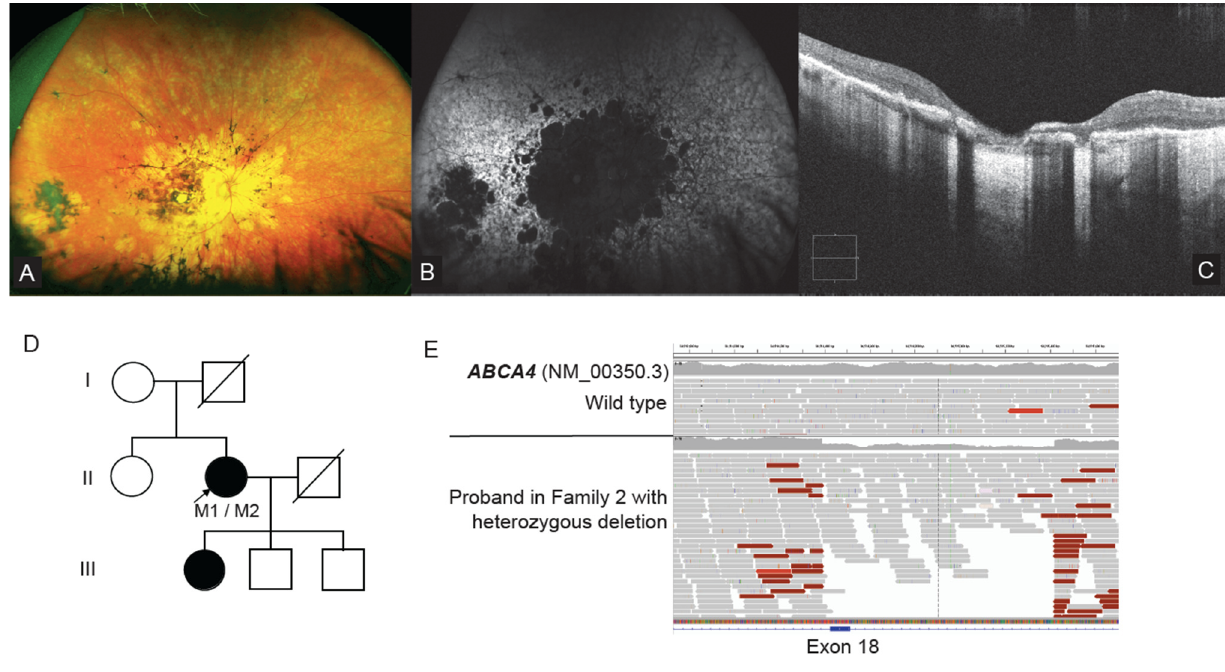
Figure 5. WGS resolves single exon CNV in ABCA4 . ( A ) Ultra-Wide field pseudo colour fundus images show significant atrophy involving the posterior pole in each eye. There was blotchy retinal atrophy extending to the equator in each eye; ( B ) UWF-FAF shows dense loss of autofluorescence in the posterior pole of both eyes extending beyond the vascular arcades with coalescing paving stone like areas of dense hypo autofluorescence. In the periphery there is patchy areas of hyper and hypo autofluorescence; ( C ) OCT showed almost complete loss of the outer retinal layers at the macular with significant disruption and loss of the EZ in the para macular region; ( D ) Pedigree of Family 6. M1 = ABCA4 :c.5461-10T>C, M2 = ABCA4 exon 18 deletion; ( E ) IGV screenshot of the 1029bp deletion involving ABCA4 exon 18, plus flanking intronic segments. Genomic deletion is describable as [hg19]chr1:94514389_94515418del. OCT Optical Coherence tomography, UWF-FAF Ultra-wide